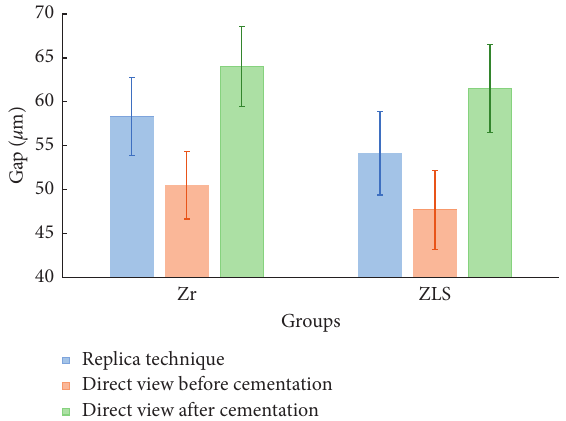
Figure 5: Mean and 95% confidence interval of replica and direct view marginal gap measurements before and after